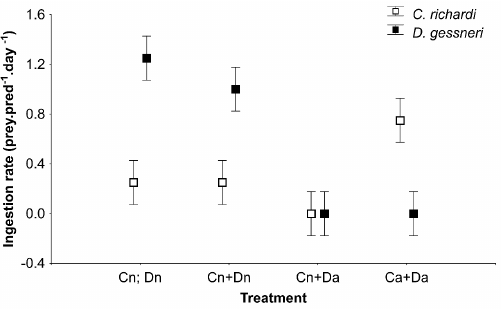
Figure 5. Ingestion rates of prey, C. richardi and D. gessneri , by the instar IV of C. brasiliensis . Cn and Dn are neonates and Ca and Da adults of the prey species, respectively. Bars are standard error of the means (±) based on four